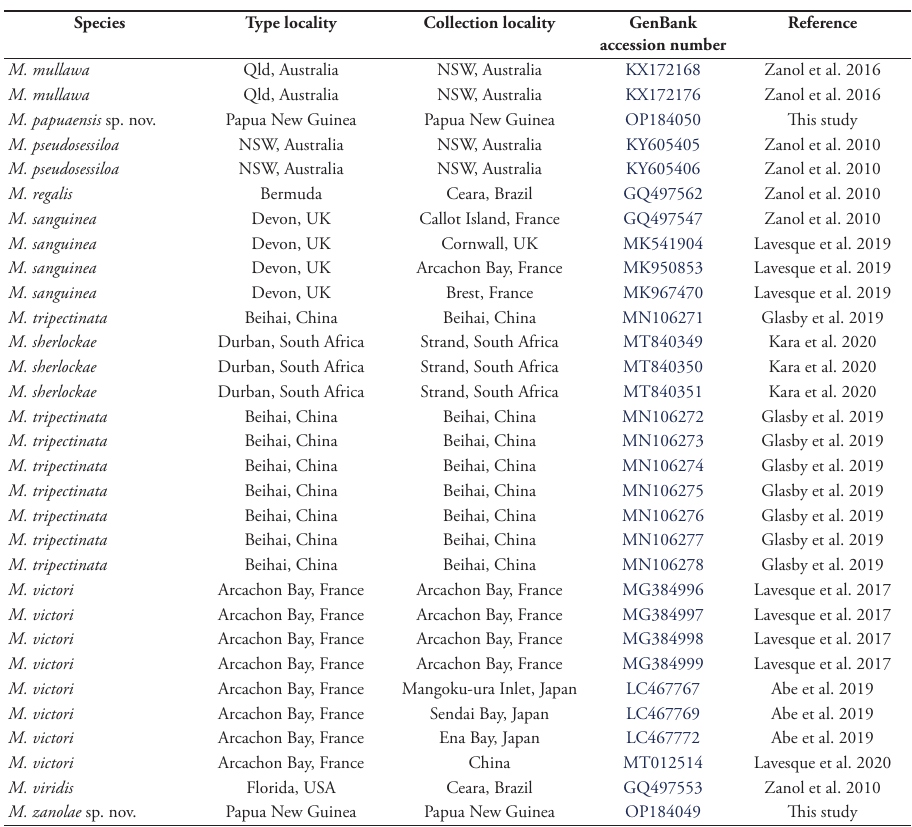
Material examined. Holotype : MNHN-IA-2015-1608, complete. Paratypes : AM W.53773, complete; AM W.53774, complete, some parapodia mounted for SEM; MNHN- IA-2021-725, anterior part only. All material collected from South Pacific Ocean, Papua New Guinea, New Ireland, CP4254, -2.483°S, 150.66°E, depth 273–324 m, April